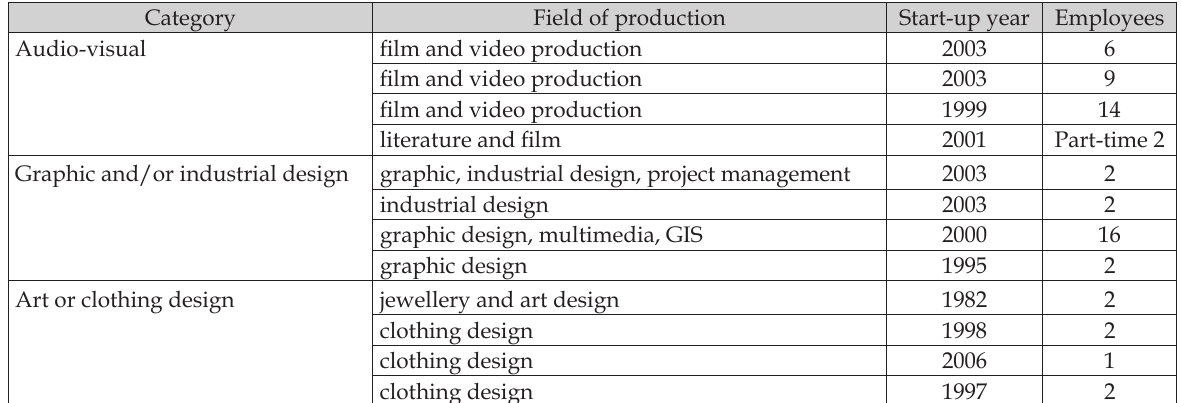
Table 2. Firm category and field of